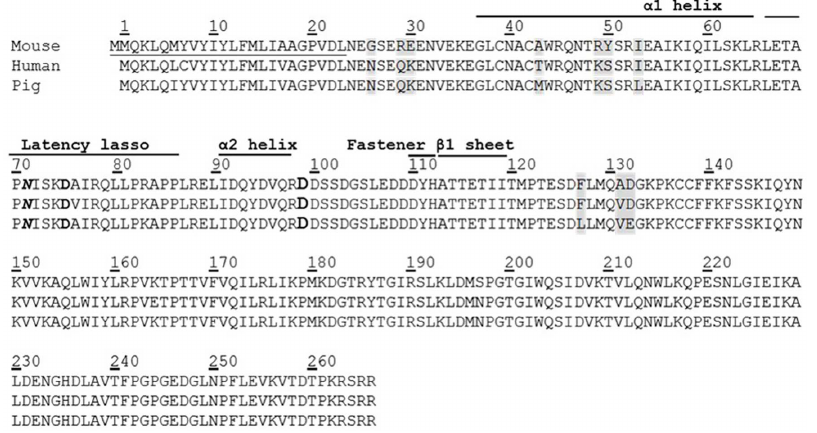
Fig 1. Amino acid sequence of pig MSTNpro aligned with those of mouse and human. Underline,bold italic characters (72), and boldcharacters (99) indicatessignal sequence,N-Gly site (n-x-s/t), and putative proteolytic site by BMP-1/TLD proteases, respectively. The shadedamino acid residues sequenceindicate different sequenceidentity amongthe three species. The domain names, including α 1 helix, latency lasso, α 2 helix, fastener, and β 1 sheet, are basedon a publicationby Shi et al.[22].